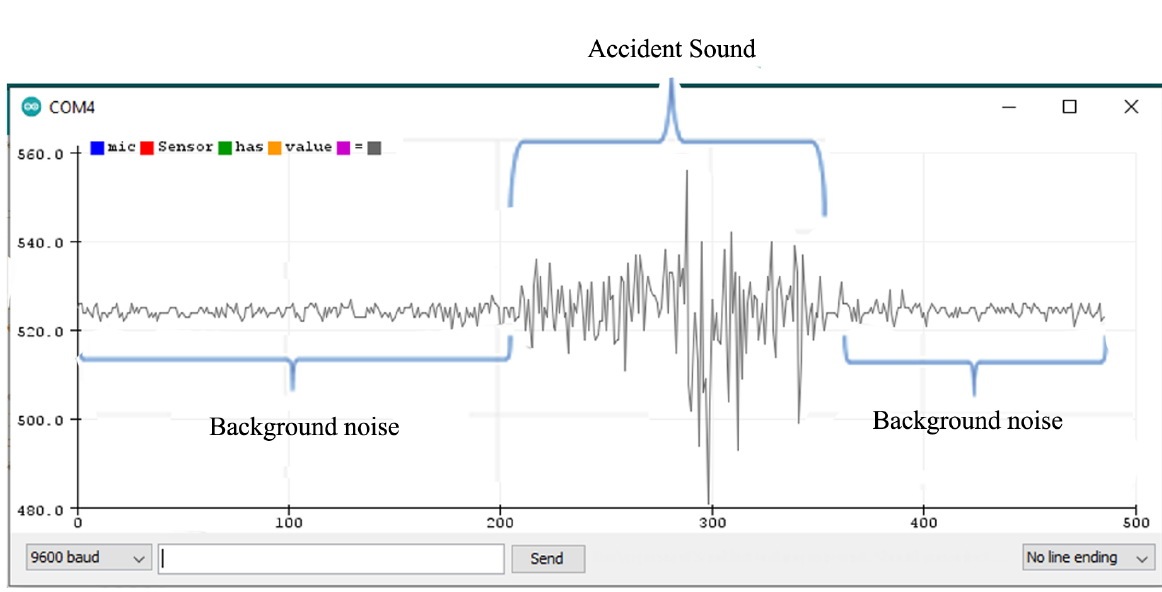
Figure 9. Microphone output on the serial